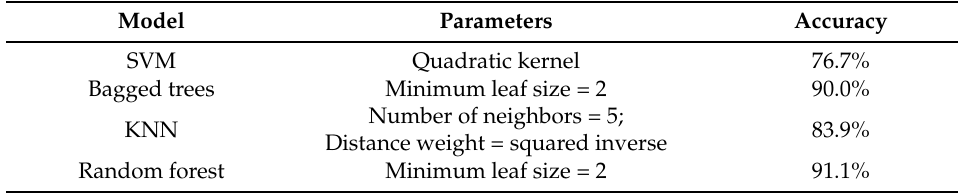
Table 3. Data set accuracy